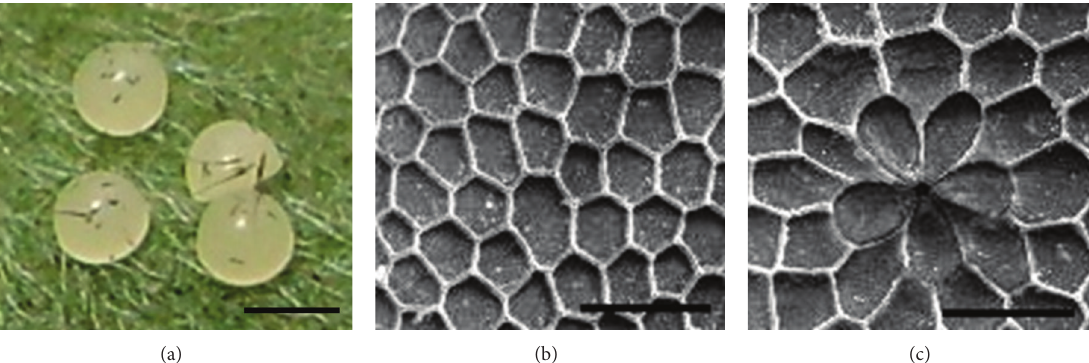
Figure 2: Cosmosoma auge eggs. General view (a), chorion surface detail (b), micropilar area (c). Scale bar represents 1mm (a) and 500 𝜇 m ((b) and (c)).